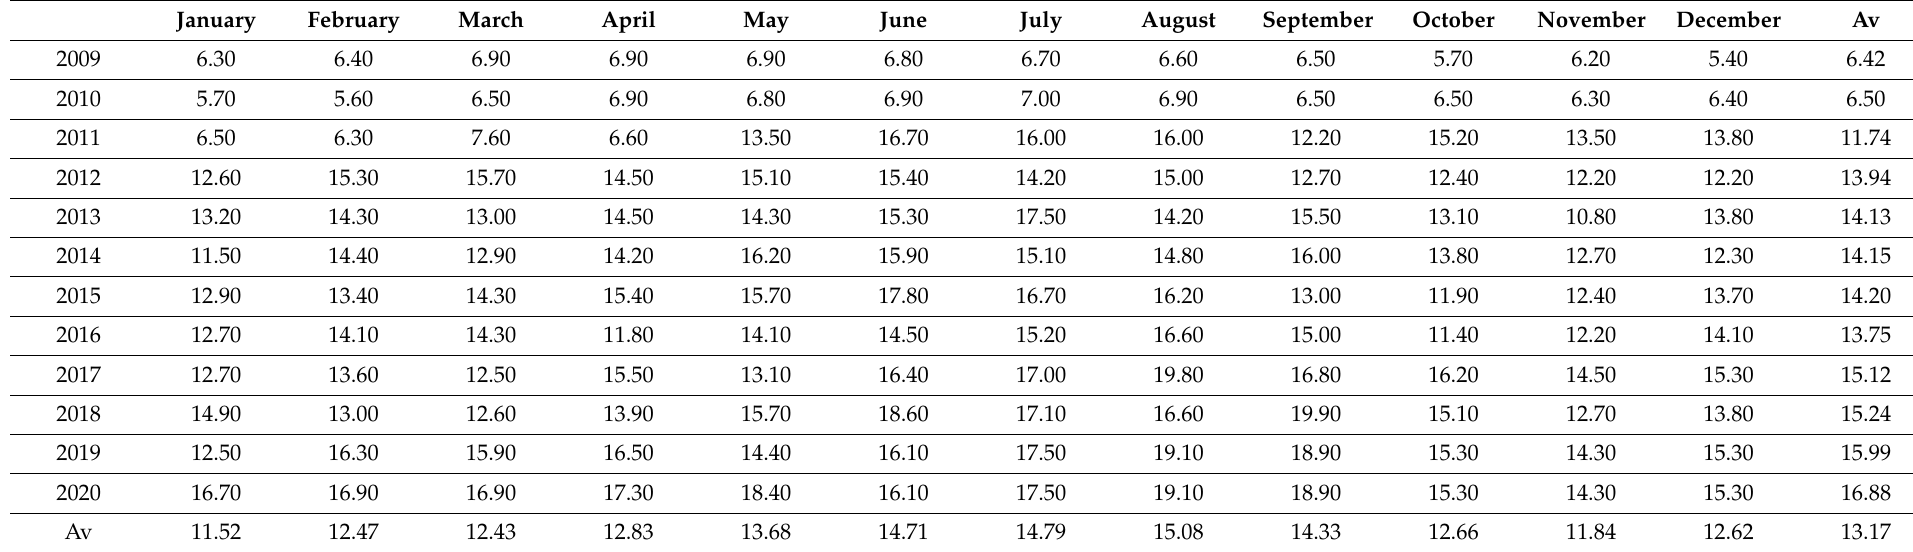
Table 2. Monthly wind speed (km/h) at Lake Nasser during the period from 2009 to